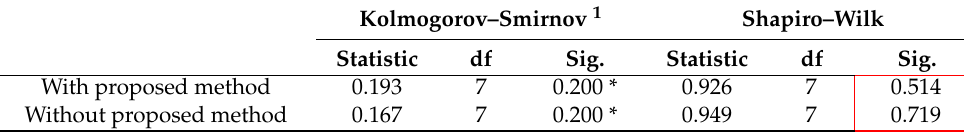
Table 14. Results of the normality test for average interaction latency for each subject.